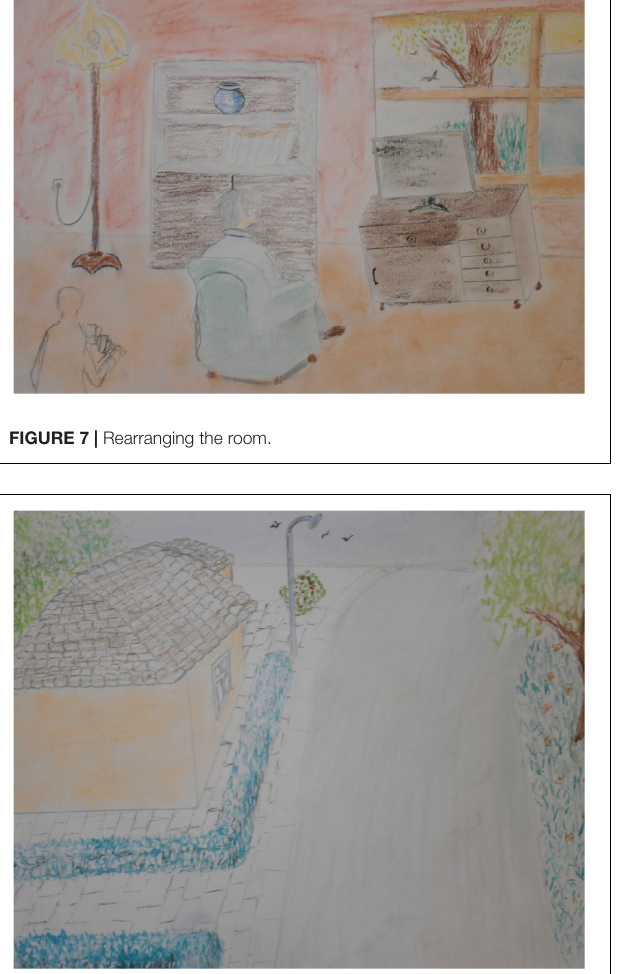
FIGURE 8 | Zooming out of the